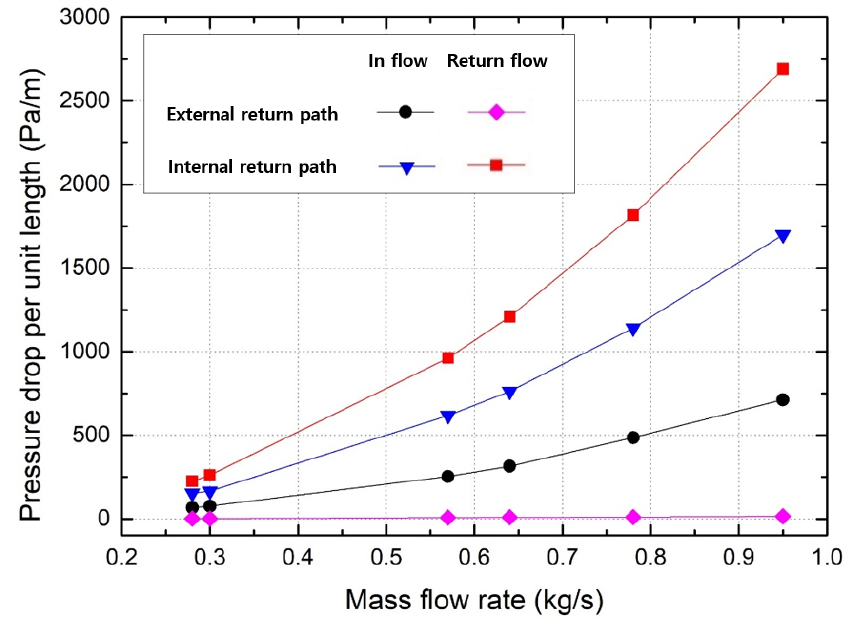
Figure 7. Pressure drop per unit length according to mass flow rate. Table 7. Equivalent relative roughness of the HTS power cable CFD